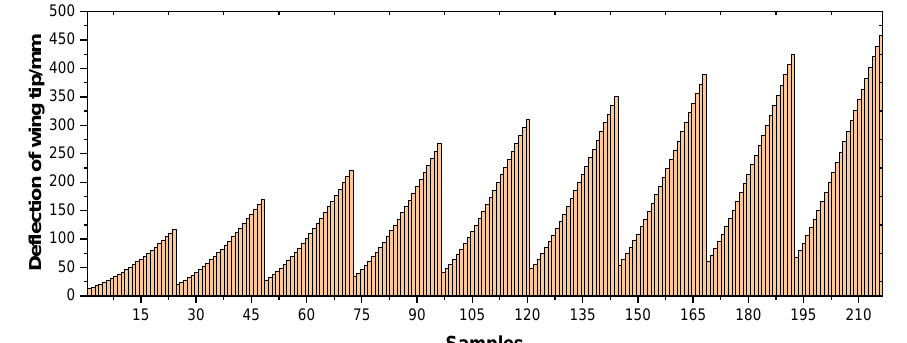
Figure 7. Samples of deflection.